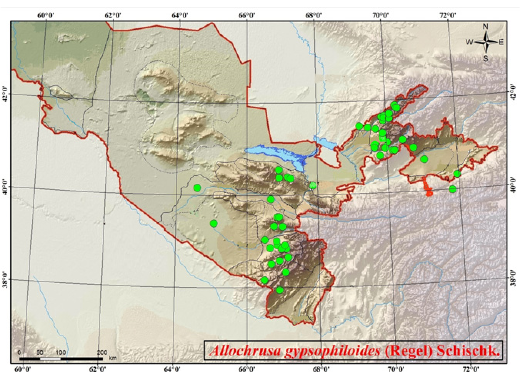
Figure 2. Distribution of A. gypsophiloides (with green dots) in the territory of Uzbekistan (https://planta-medica.uz/, accessed on 3 January 2023).